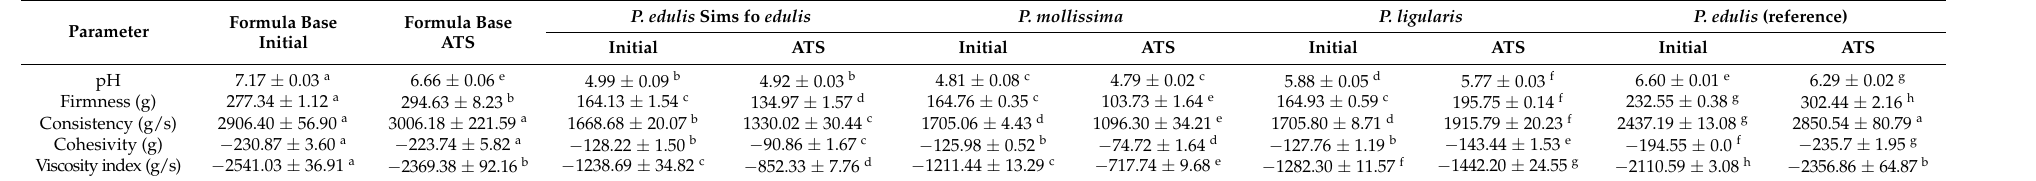
Table 3. Characterization of exfoliant prototypes (obtained by Process B) before and after thermal shock